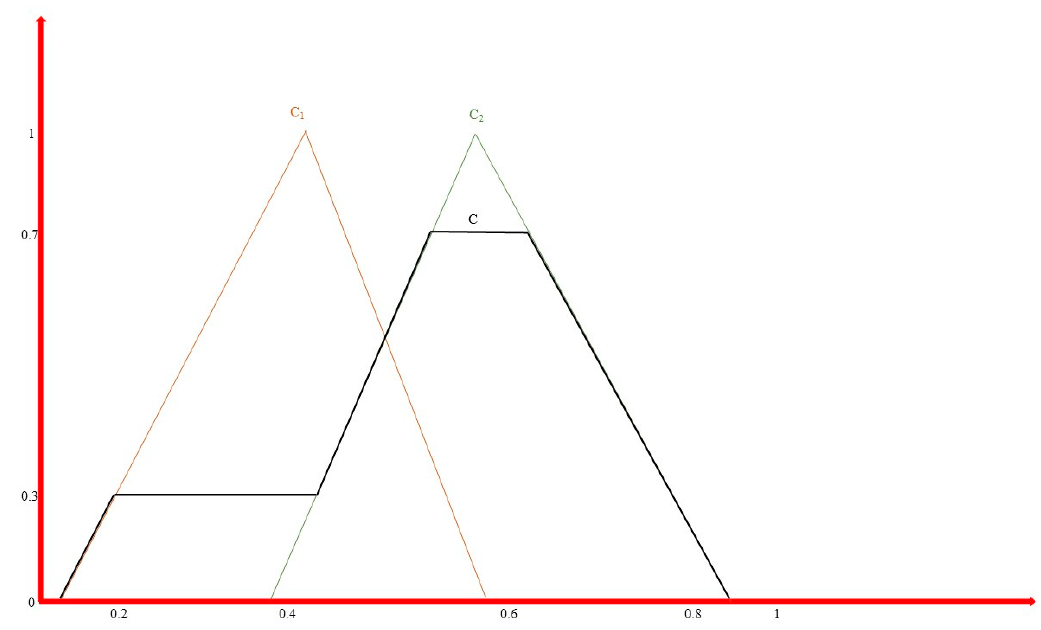
Figure 4. Example of construction of the output fuzzy set in the aggregation process.